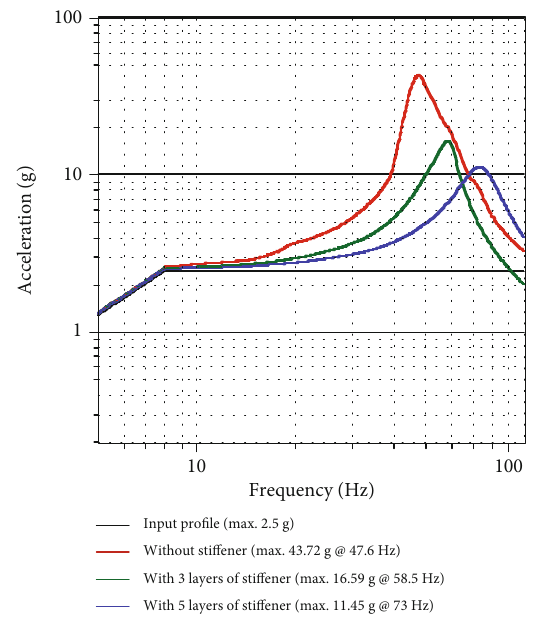
Figure 11: Random vibration test results of the solar panels in the z -axis